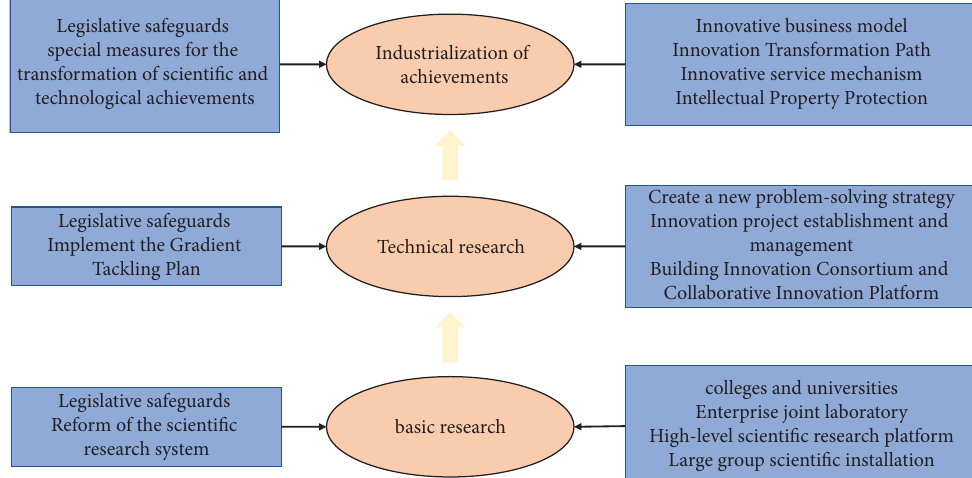
Figure 1: Main chain of the scientifc and technological innovation ecological chain.